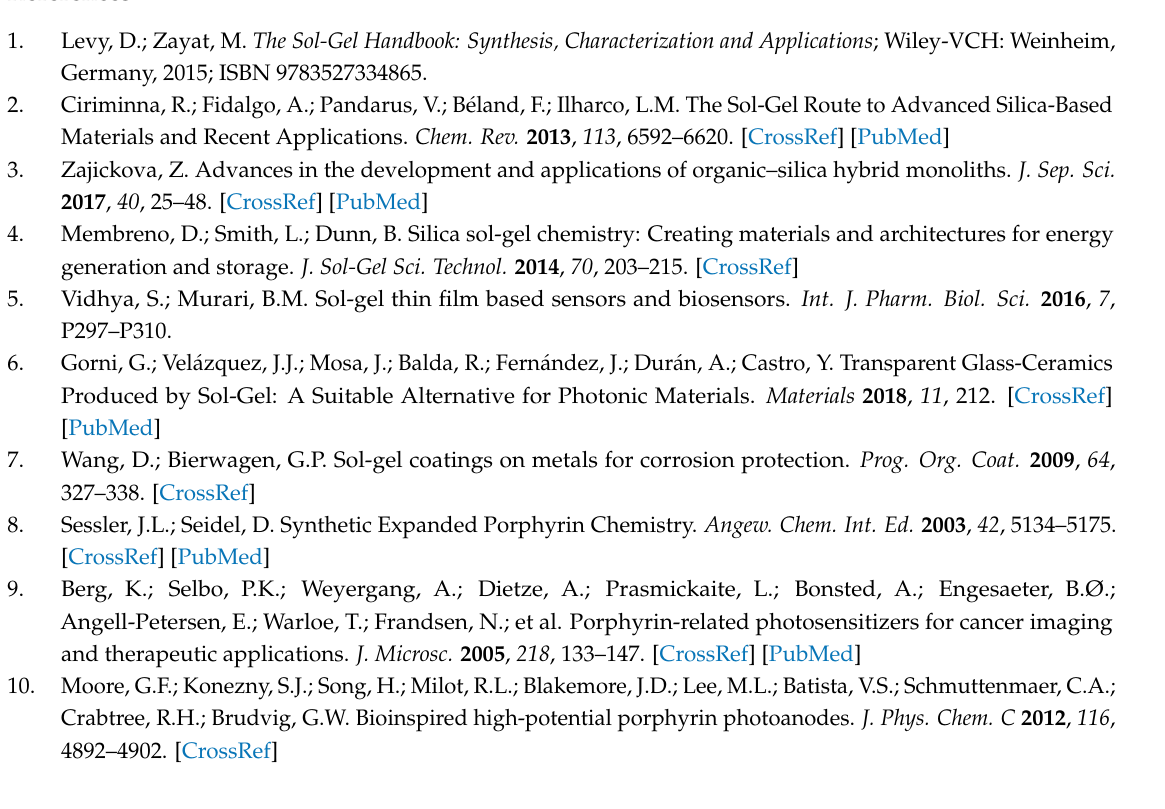
Figure S1. Nitrogen adsorption-desorption isotherms evolution in function of the vinyl substitution ratio; Figure S2. Pore size distribution from DFT method; Figure S3. Evolution of the total pore volume vs. micro pore volume for the samples without (a) and with porhyrin (b); Figure S4. SAXS curves of the A and B series of samples. Mole percentage of VTAS is shown in the legend. Symbols represent the measured data, lines are the fitted curves; Figure S5. Size distribution of nanoparticles determined from the TEM images; Figure S6. Comparative study of the FT-IR spectra obtained from using different VTAS/TEOS xerogels; Table S1. Assignment of FT-IR